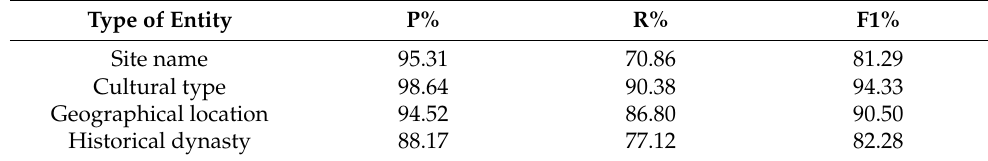
Table 7. Experimental results of BiLSTM-CRF model.